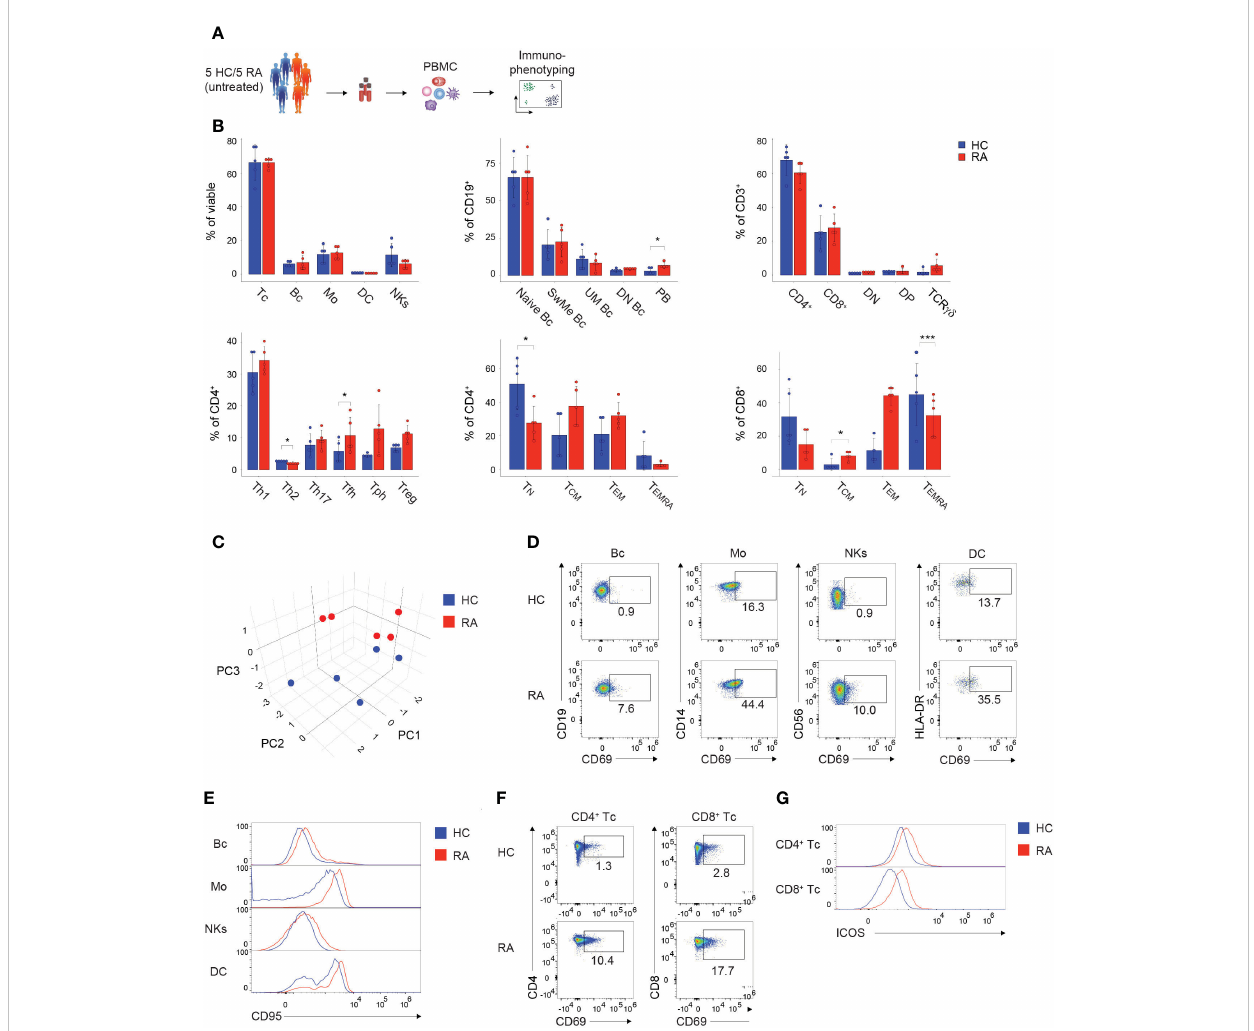
FIGURE 5 Immunophenotyping of patients suffering from autoimmune diseases. (A) Schematic illustration of the work fl ow. Frozen PBMCs of 5 naïve, untreated, female RA patients and 5 sex-matched and age-matched HCs were thawed and directly subjected to immunophenotyping using the established PBMC and T cell panel. (B) Bar charts depicting the percentages of the indicated subsets within viable PBMCs (left, top), CD19 + B cells (middle, top), CD3 + T cells (right, top), CD4 + T cells (left, bottom), CD4 + T cells (middle, bottom), and CD8 + T cells (right, bottom). Each symbol indicates 1 independent biological sample. Statistical comparisons were done by Student ’ s t-test, comparing the 5 individual replicates of RA patients to HC. Signi fi cance was de fi ned as p-value (*P < 0.05 and ***P < 0.001). (C) 3-dimensional PCA depicting the combined activation marker expression levels resulting from the immunophenotyping using the PBMC and T cell panel. Each symbol indicates 1 independent biological sample. Blue dots show HCs and red dots illustrate RA patients. (D, F) Spectral fl ow cytometry analysis showing CD69 expression in the indicated (D) PBMC and (F) T cell subsets of 1 representative HC and RA patient, respectively. Numbers indicate the percentage of cells in the quadrants or gates. (E, G) Histograms showing (E) CD95 expression or (G) ICOS expression in the indicated (E) PBMC and (G) T cell subsets of 1 representative HC and RA patient, respectively. (B – E) The DC subset encompasses pDCs and mDCs. Data are representative (D – G) or show a summary (B, C) of at least 3 independent experiments. DC, dendritic cells; Mos, monocytes; NKs, natural killer cells; Bc, B cells; Tc, T cells; N, naïve; UnMe, unswitched memory; SwMe, switched memory; DN, double-negative; DP, double-positive; T N , naïve T cells; T CM , central memory T cells; T EMRA , terminally differentiated effector T cells; T EM , effector memory T cells; Th, T helper cells; Treg, regulatory T cells; Tfh, T follicular helper cells; Tph, T peripheral helper cells; RA, Rheumatoid arthritis; HC, healthy control; PCA, Principal Component